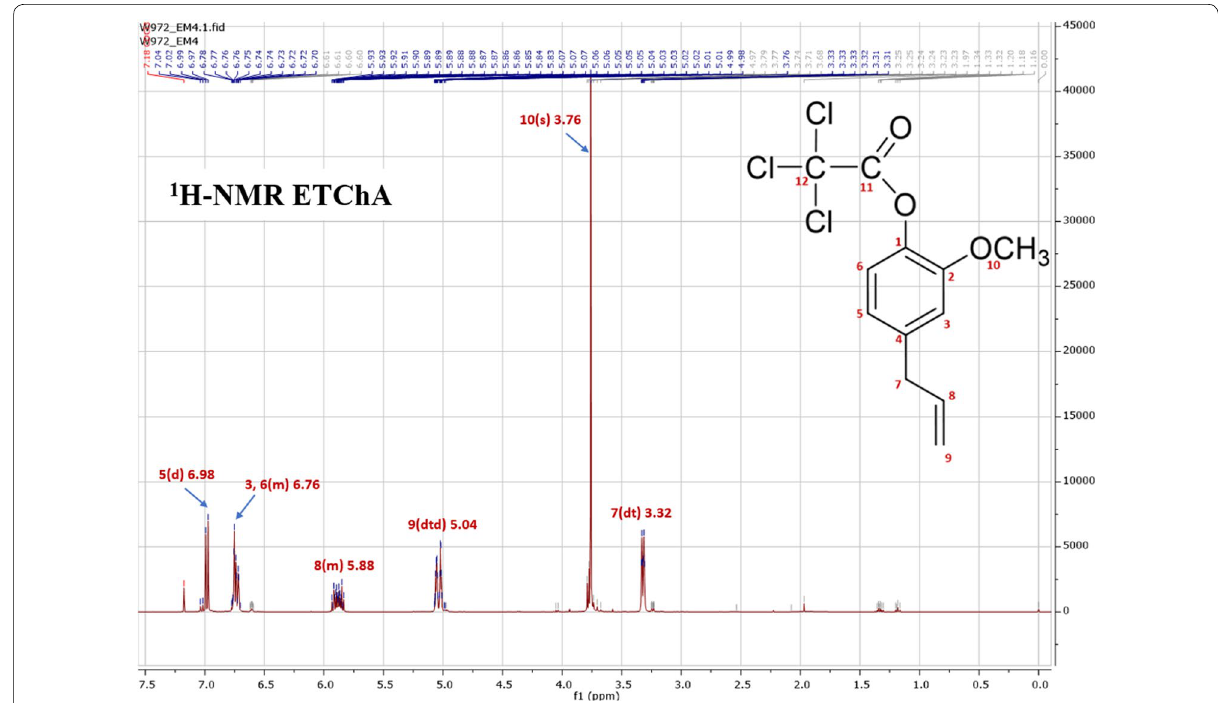
Fig. 1 1 H-NMR spectrum of